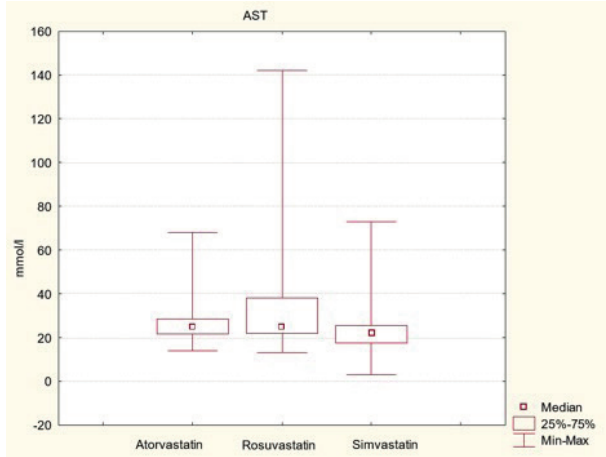
Figure 3 - Group differences in the level of aspartate transferase (AST) depending on the choice of statin The most commonly prescribed statins in the analysis of the data obtained in the study group were Crestor and Zocor (see Table 3).